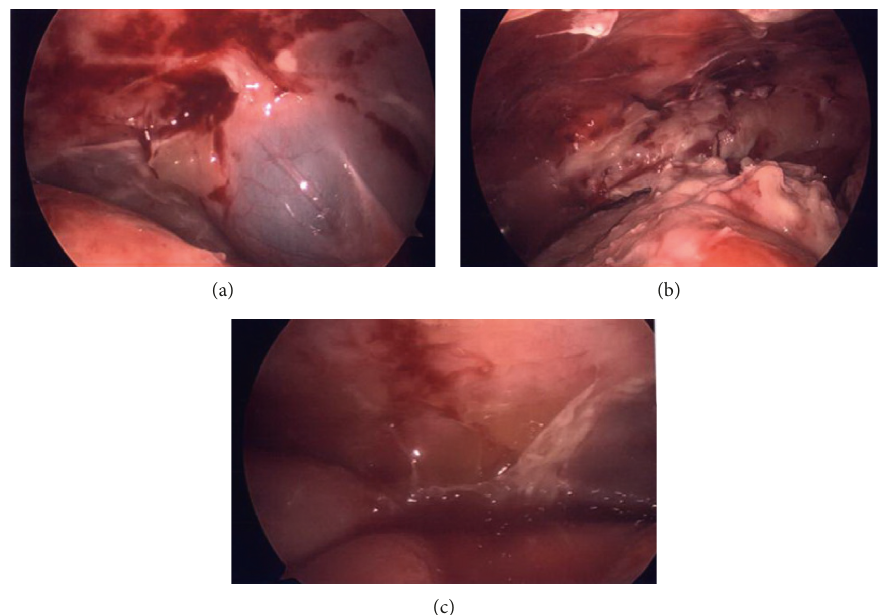
Figure 2: Diagnostic laparoscopy findings: inflamed peritoneum with densely adhered gallbladder to liver (a); fibrinous exudate throughout the peritoneal cavity (b); gelatinous ascites